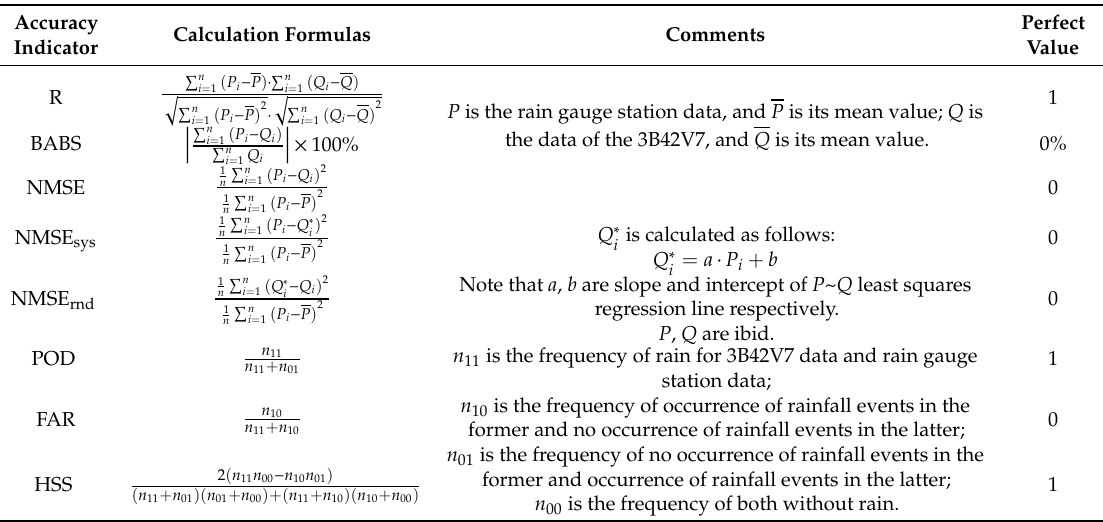
Table 1. Formulas of the accuracy